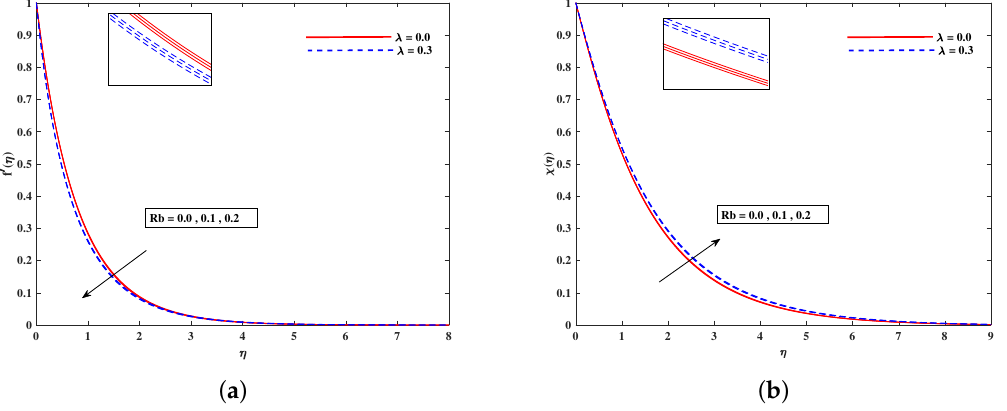
Figure 6. Fluctuation of Rb on velocity f (cid:48) ( η ) ( a ) and bioconvection profile χ ( η ) ( b ).